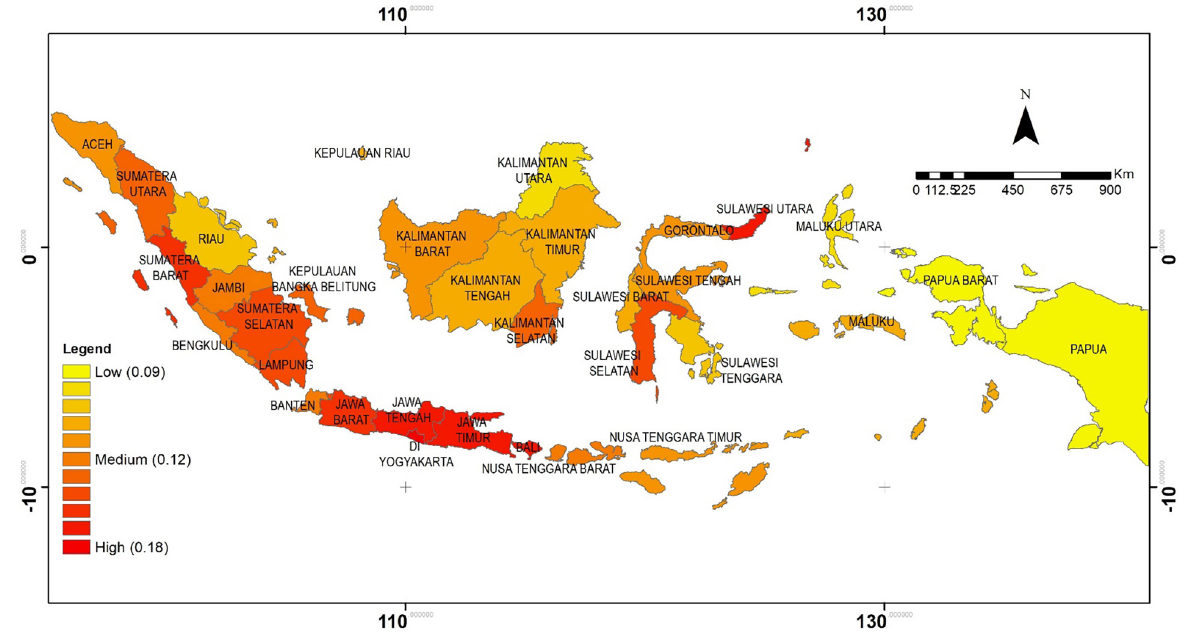
Fig. 6. VLN of COVID-19 between March 2020 and March 2021. VLN – vulnerability.